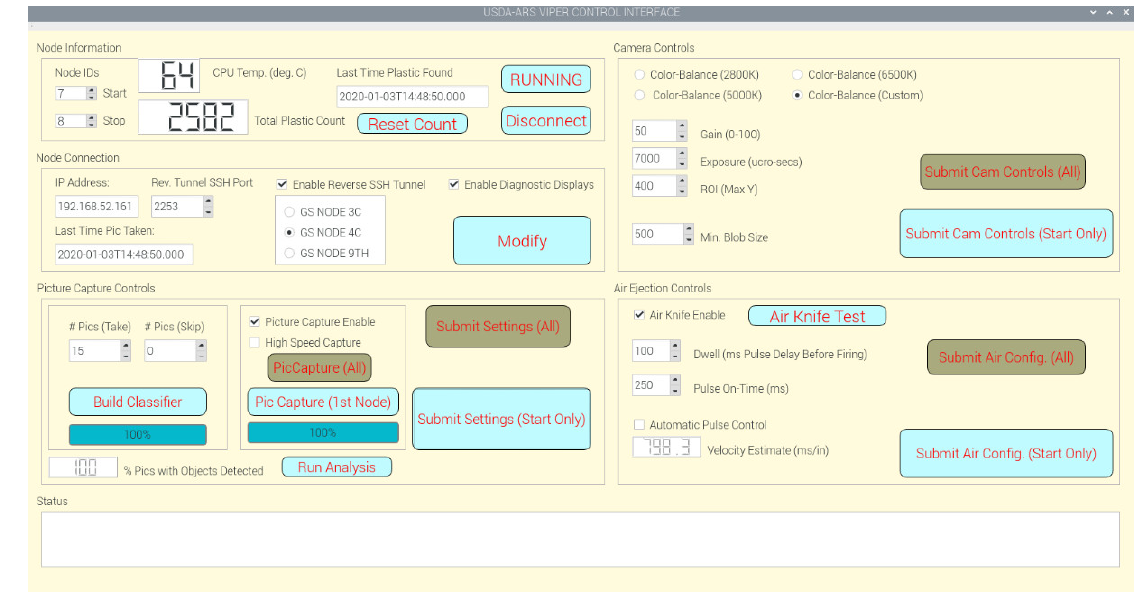
Figure 11. Screenshot of the PIDES-Viewer software that provides the user interface to the machine-vision plastic detection system.